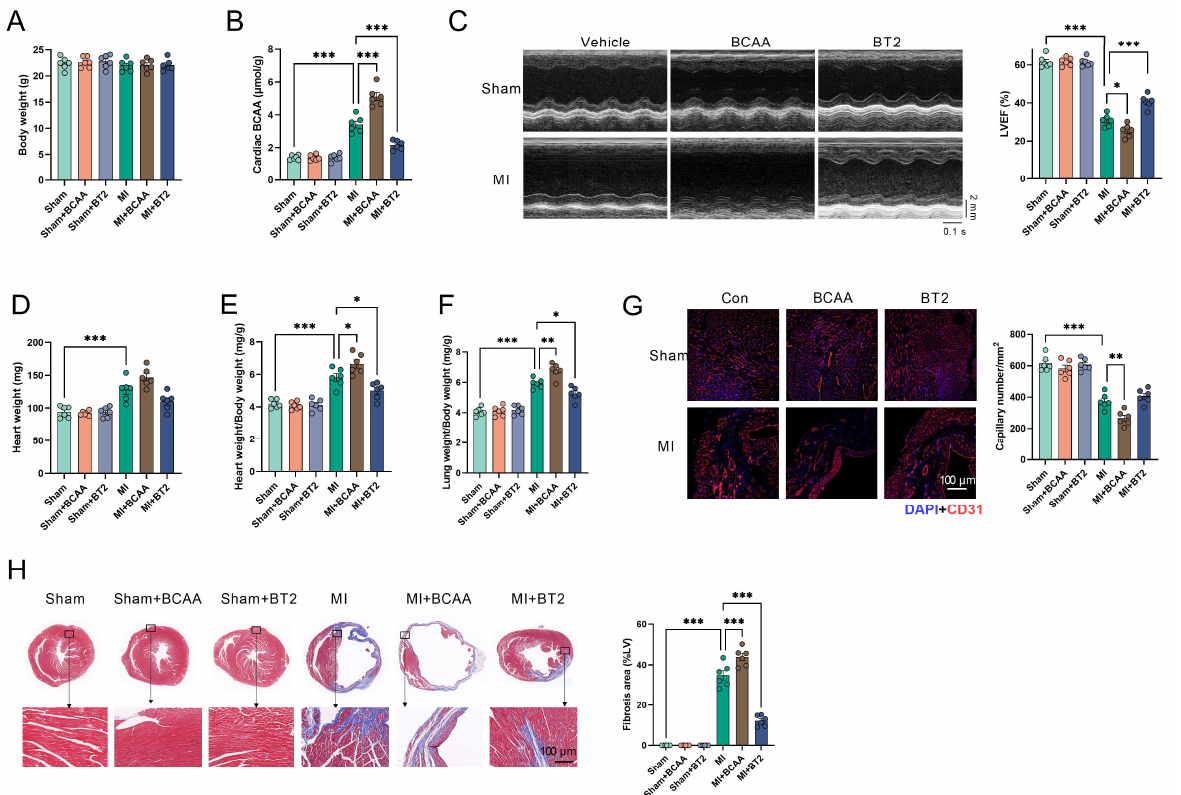
Figure 3. Enhancement of BCAA catabolism protected the heart against MI. Mice were subjected to sham or MI operation and treated with either BCAA or BT2 post-surgery for 4 weeks. All parameters were detected at 4 weeks post-surgery. ( A ). Body weight of mice. ( B ). Cardiac BCAA levels in sham and MI mice. ( C ). Enhancement of BCAA catabolism by BT2 increased the left ventricular ejection fraction (LVEF) in mice with MI. ( D ). Heart weight in sham and MI mice. ( E ). Heart weight–body weight ratio in sham and MI mice. ( F ). Lung weight–body weight ratio in sham and MI mice. ( G ). Cardiac capillary density in the ischemic territory near the non-infarct area as detected by CD31 fluorescence in sham and MI mice. ( H ). Enhancement of BCAA catabolism by BT2 decreased cardiac fibrosis as detected by Masson staining in mice with MI. The blue staining indicates collagen and fibrosis. Values are presented as mean ± SEM. n = 6. * p < 0.05; ** p < 0.01; *** p <